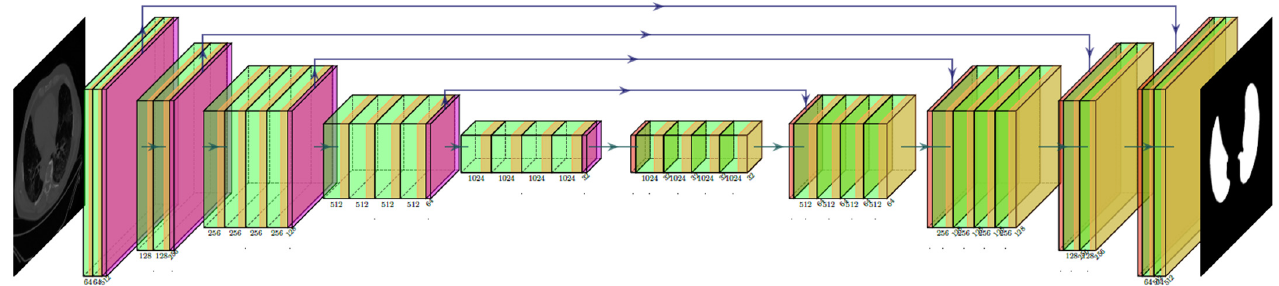
Figure 5. VGG-SegNet architecture.